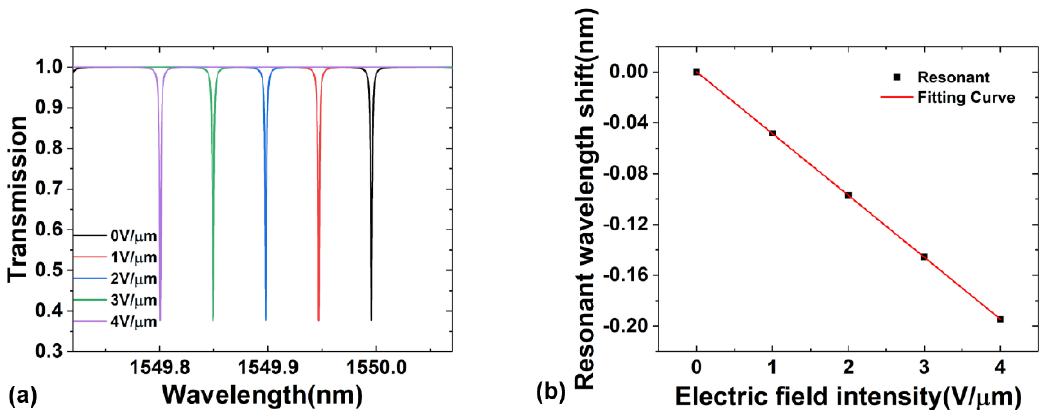
Figure 9. ( a ) The transmission spectrum and ( b ) wavelength offsets of the microring when the electric field intensity is 0 V/μm, 1 V/μm, 2 V/μm, 3 V/μm and 4 V/μm, respectively. 0 V/ µ m, 1 V/ µ m, 2 V/ µ m, 3 V/ µ m and 4 V/ µ m,